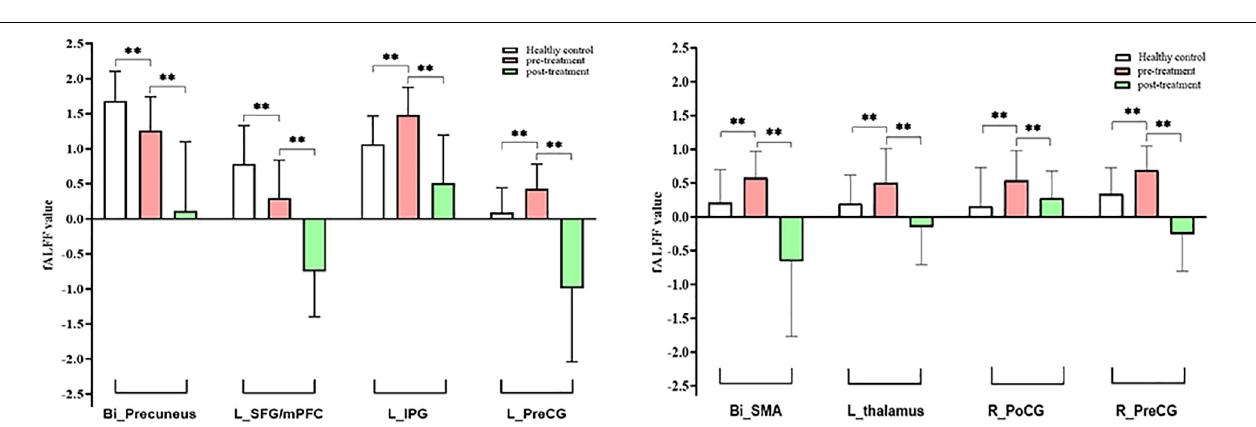
FIGURE 4 | Intergroup and intragroup comparison of fALFF differences. Compared with HCs, pretreatment MWoA patients exhibited increased fALFF in the left thalamus, left IPG, bilateral PreCG, right PoCG, and bilateral SMA, but decreased in the bilateral precuneus and left SFG/mPFC; compared with pretreatment MWoA patients, migraineurs receiving 4-week taVNS treatment showed decreased fALFF in the left thalamus, bilateral PreCG, right PoCG, bilateral SMA, left IPG, bilateral precuneus, and left SFG/mPFC, but no significantly increased brain regions. White color represents healthy control; red color represents pretreatment migraine patients; green color represents posttreatment migraine patients. Bi, bilateral; R, right; L, left; PoCG, postcentral gyrus; PreCG, precentral gyrus; SMA, supplementary motor areas; SFG, superior frontal gyrus; mPFC, medial prefrontal cortex; IPG, inferior parietal gyrus. The ∗∗ represents that the difference is statistically